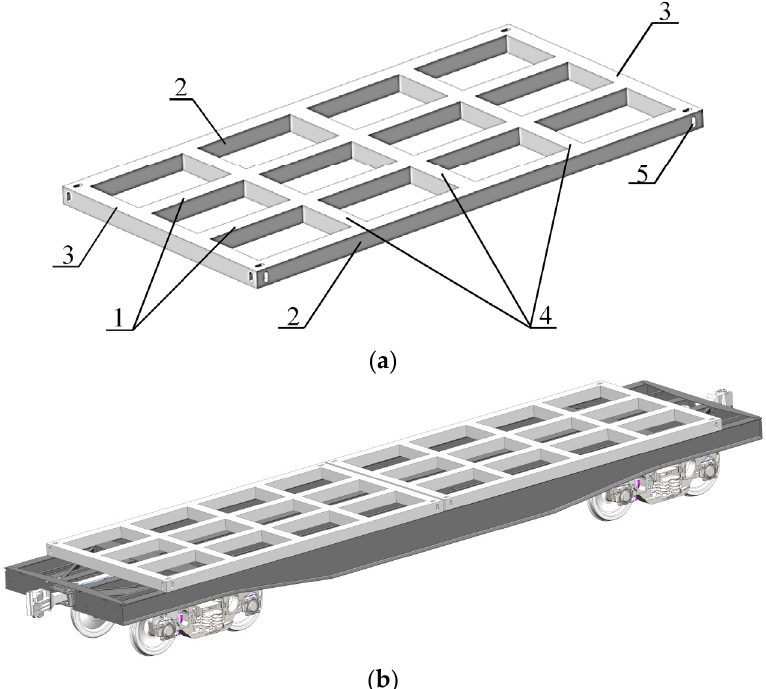
Figure 1. FLAT RACK removable module: ( a ) Structural elements of the removable module; ( b ) removable module on a flat wagon.